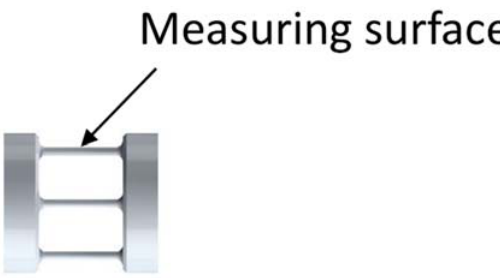
Figure 6. Position for surface roughness measurements on all four struts.